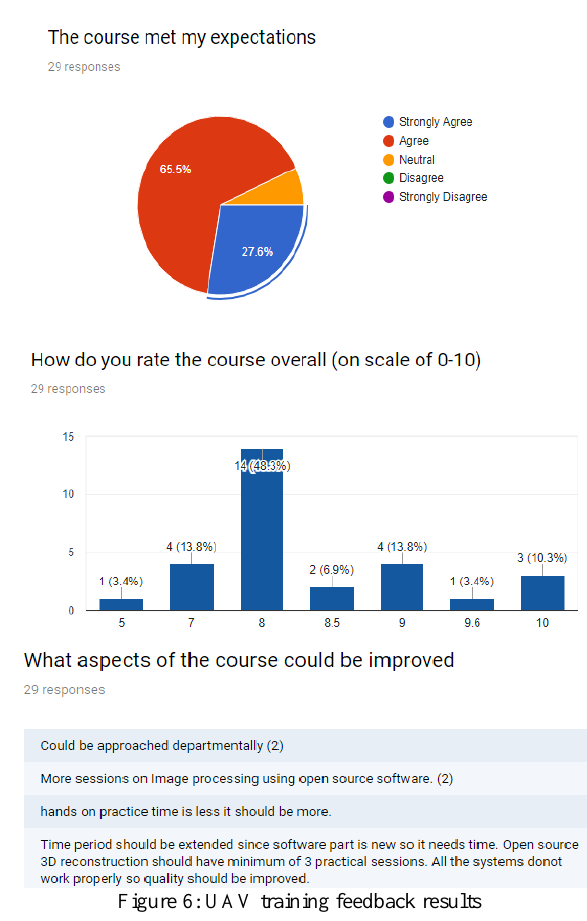
Figure 6: UAV training feedback results 4.2 User specific UAV trainings at NESAC